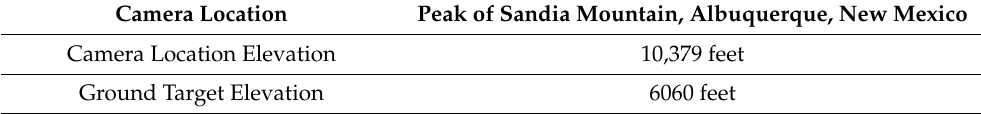
Table 3. Camera Specifications.